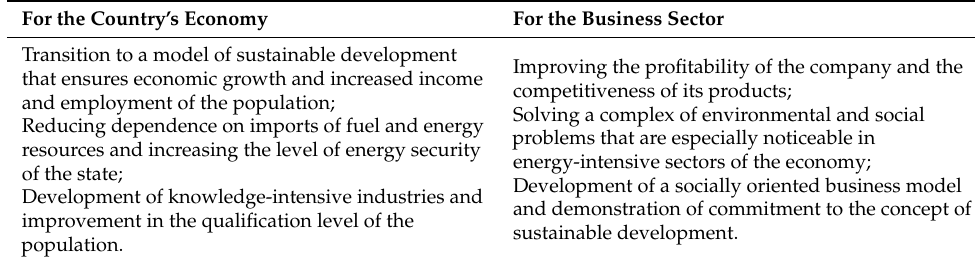
Table 5. Benefits of increasing the level of energy efficiency. Note: compiled by the authors according to the data UNEP «Green Energy Choices: The Benefits, Risks and Trade–Offs of Low–Carbon Technologies for Electricity Production; Summary for Policy Makers» [Report UNEP, p.